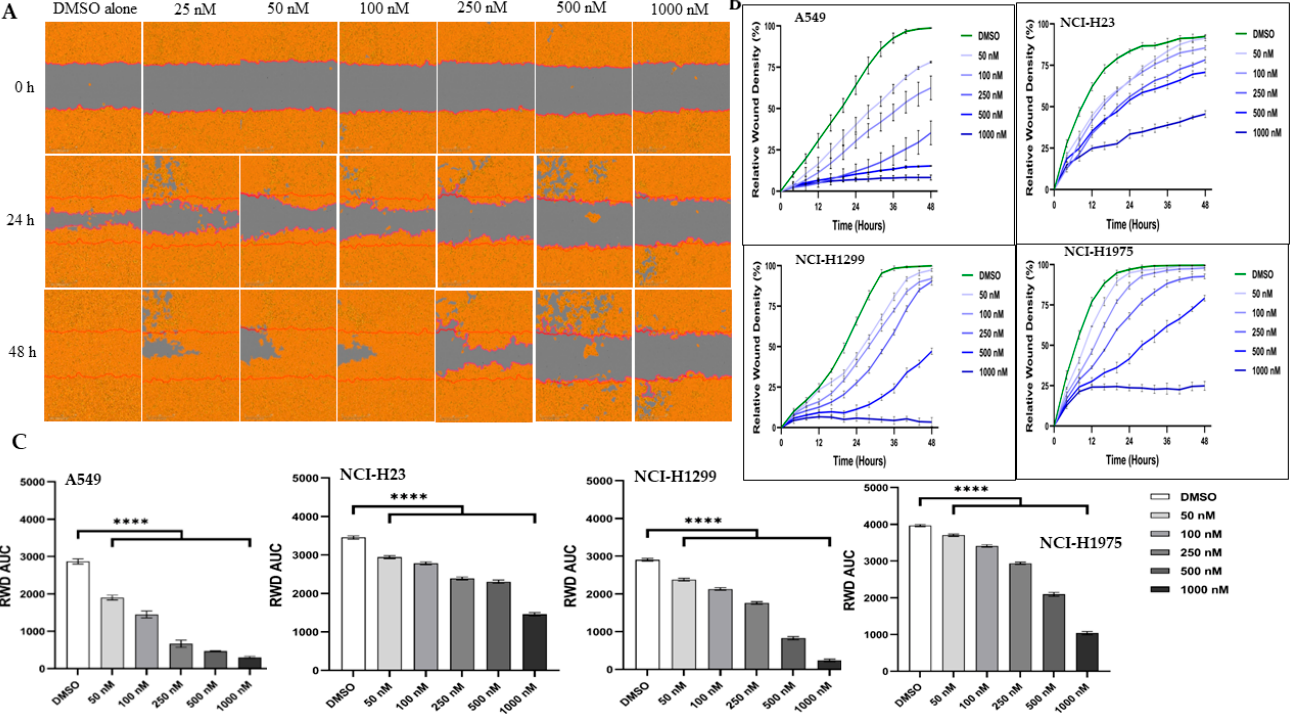
Figure 5. KAN0441571C inhibited migration of lung cancer cell lines in the scratch wound healing assay. ( A ) Migration of A549 was inhibited as shown by images acquired after 0, 24, and 48 h of incubation with different concentrations of KAN0441571C. Images of 1 representative experiment out of 4 for each cell line is shown. ( B ) Rate of wound closure (relative wound density) of lung cancer cells. The Incucyte Zoom Imager Software Analyzer was used to count the number of lung cancer cells during 48 h of incubation with of KAN0441571C (25–1000 nM). DMSO used as control. ( C ) Reduction (mean ± SEM) of cell migration (RWD AUC) after treatment with KAN0441571C (0–1000 nM) in 4 cell lines. **** p < 0.0001.